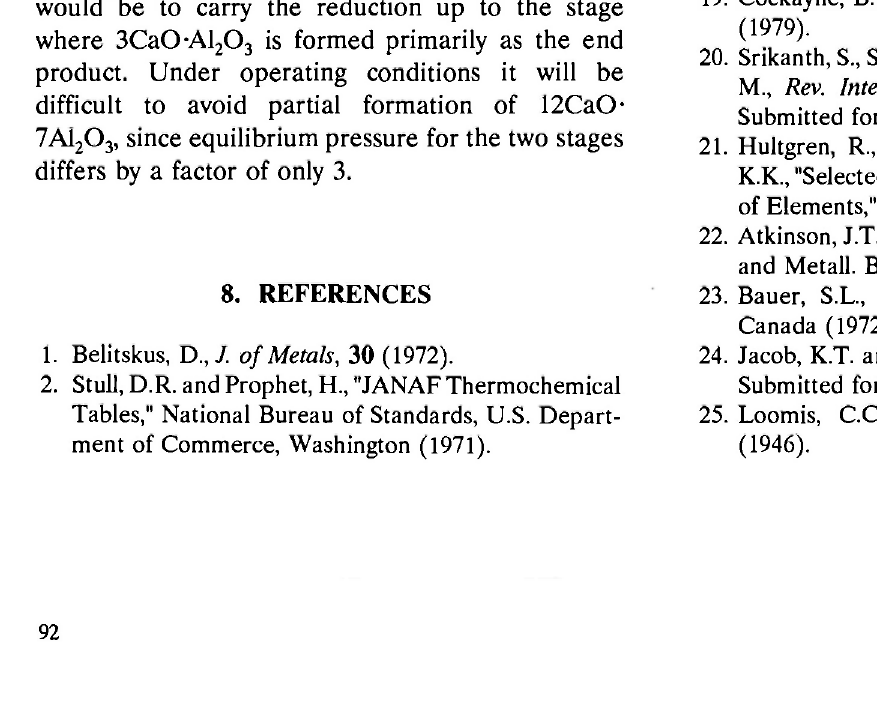
Tables," National Bureau of Standards, U.S. Depart- ment of Commerce, Washington